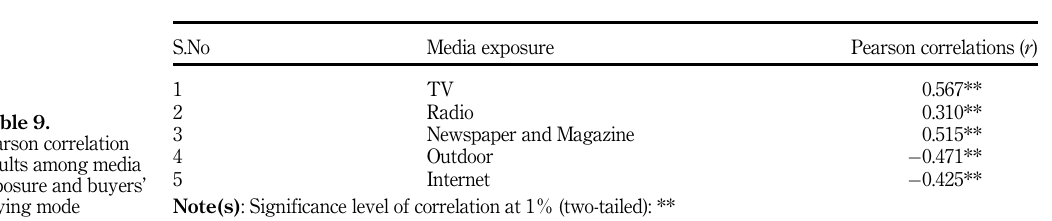
Table 8. Results of ANOVAs